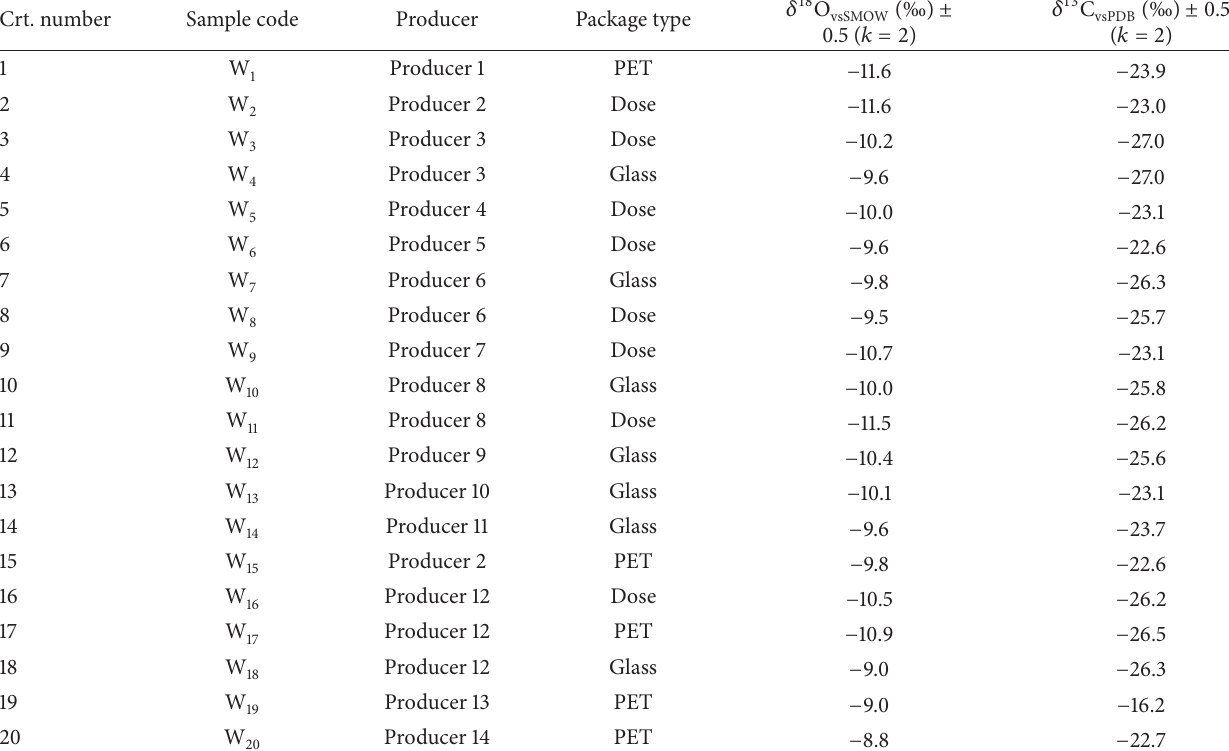
Table 3: The isotopic values ( 𝛿 13 C and 𝛿 18 O) of investigated beers. Crt.